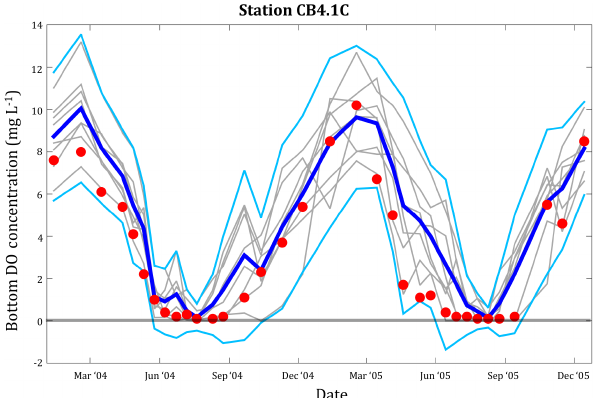
Figure 9. Time series of bottom dissolved concentrations for station CB4.1C. Red dots represent the 34 observations made during 2004– 2005. Grey lines are the individual model simulations. The dark blue line represents the Model Mean while the cyan line represents the 95% confidence interval of the model simulations.